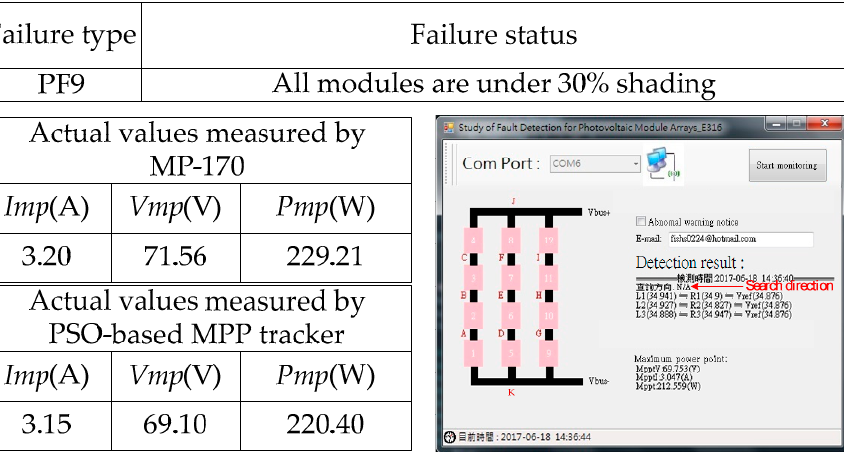
Figure 24. Experimental outcome for failure type PF9.